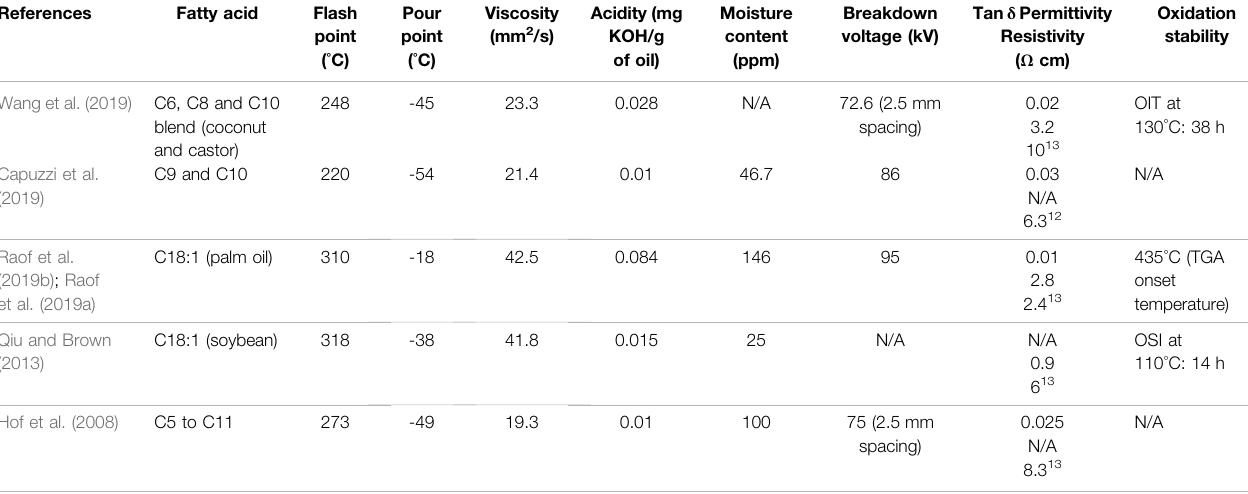
TABLE 8 | Previous studies on the application of TMPE as a transformer-insulating